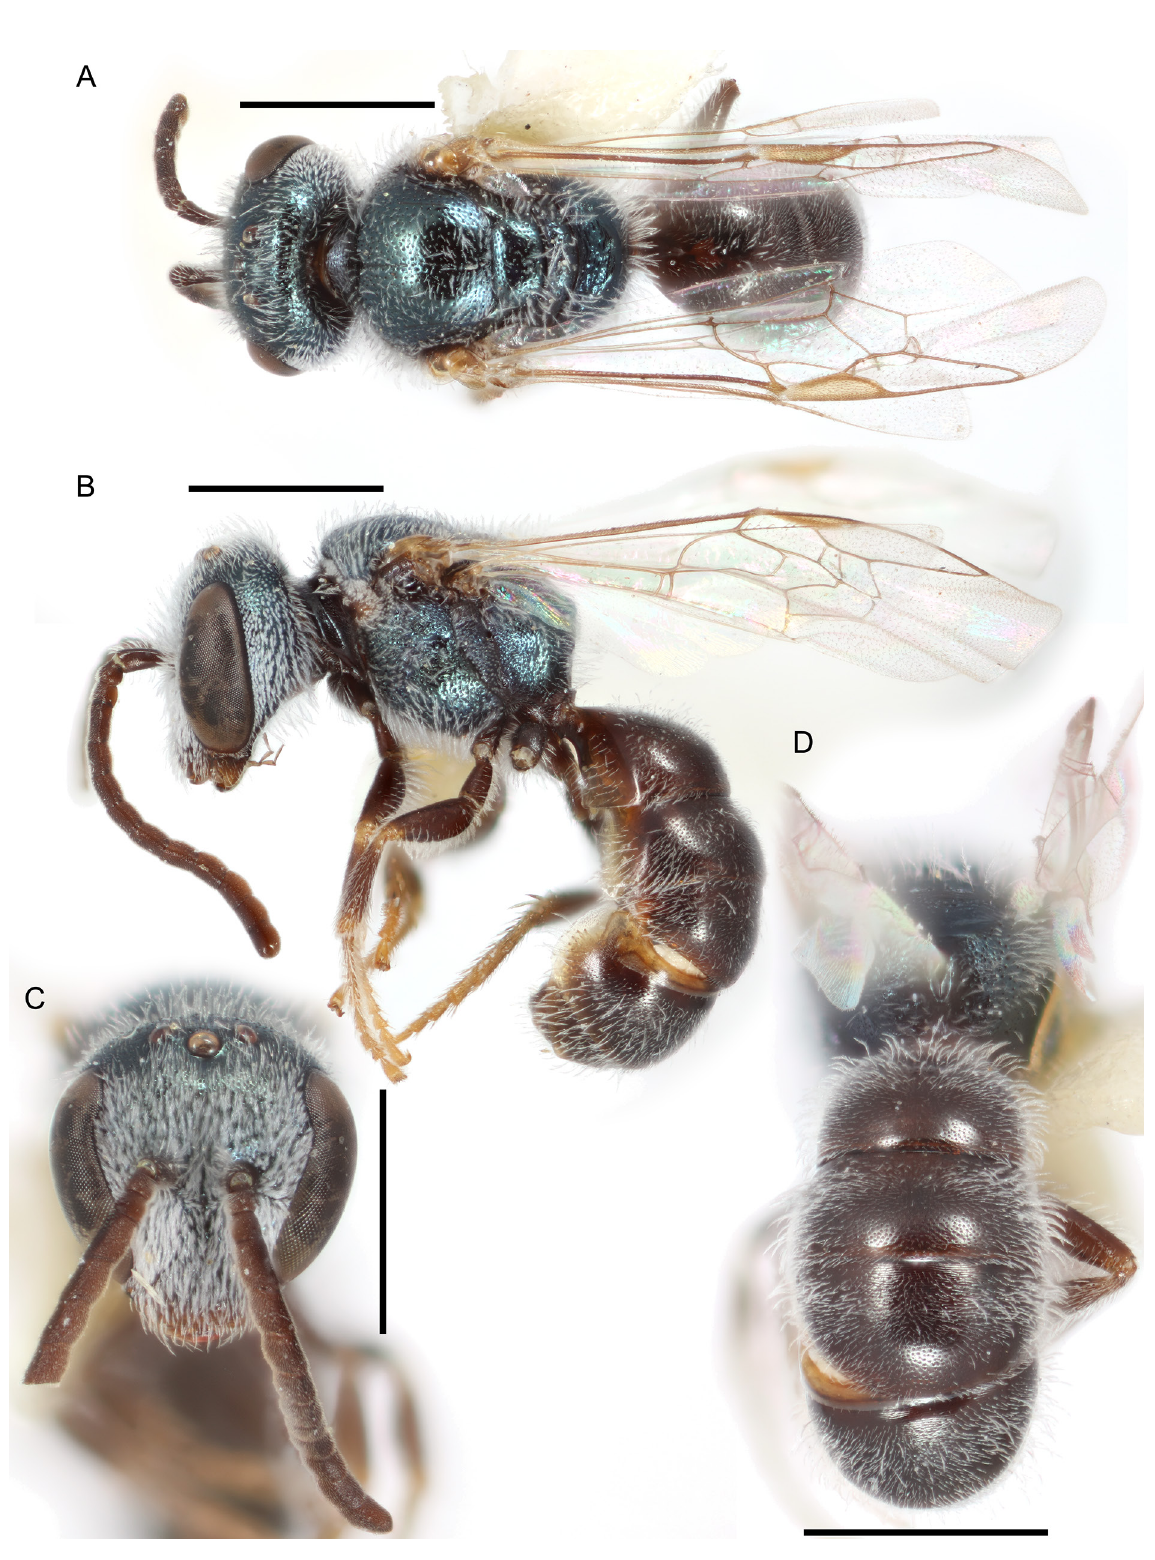
Fig. 17. Lasioglossum ( D. ) cactorum sp. nov., ♂. A . Dorsal habitus. B . Lateral habitus. C . Face. D . Propodeum and metasoma. Scale bars: 1